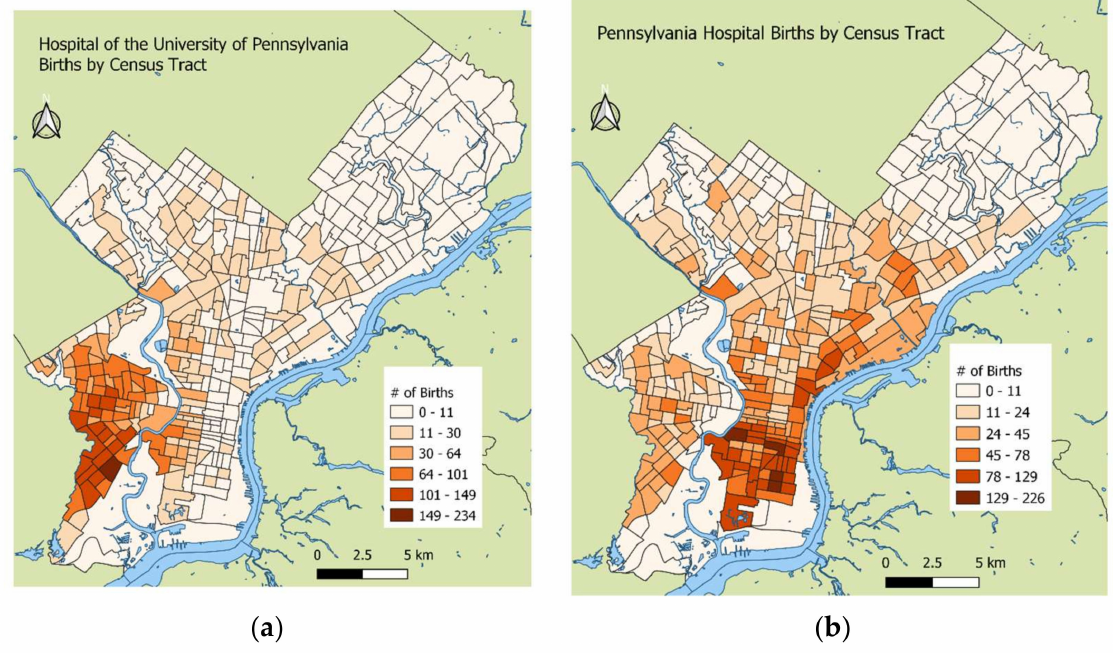
Figure 3. Number of births per census tract by hospital: ( a ) Hospital of the University of Pennsylvania;